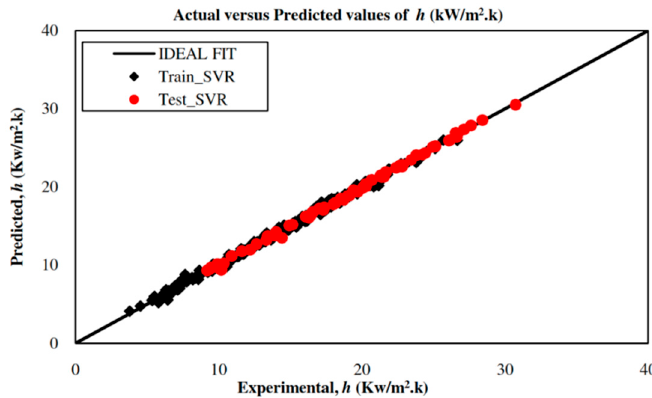
Figure 5. SVR simulation of heat transfer coefficient of R600a using the optimal parameters.